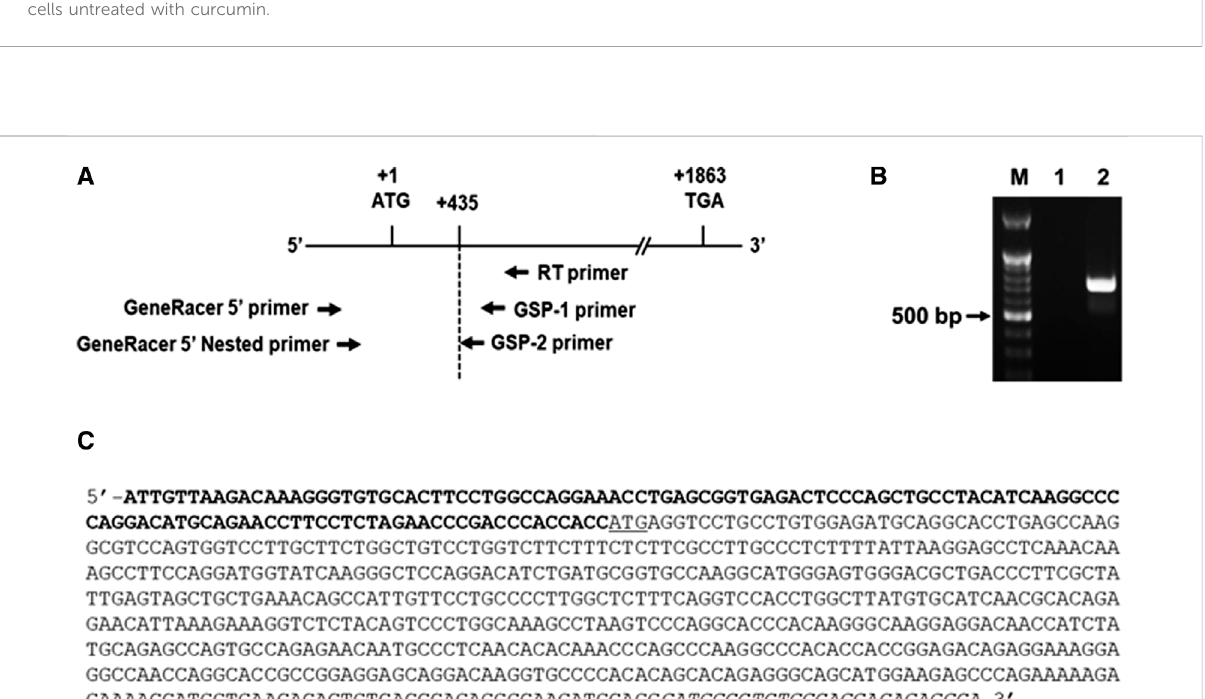
FIGURE 2 FlowcytometricanalysisofsialylTnantigenusinganti-sialylTnantibodyincurcumin-treatedHCT116cells.After50 μ Mcurcumintreatmentfor 24h, The cells(1 ×10 6 cells)wereanalyzed by fl ow cytometry after incubation withanti-sialylantibodyincombinationwith thecorresponding Alexa Fluor488-conjugatedgoatanti-mouseIgGH&Lsecondaryantibody.Whiteand fi lledgreyareasrepresentthehistogramsforcellstreatedwith0and 50 μ M curcumin, respectively. Results are presented as the means ± SEM of three independent experiments. * p < 0.05 compared with control cells untreated with curcumin.